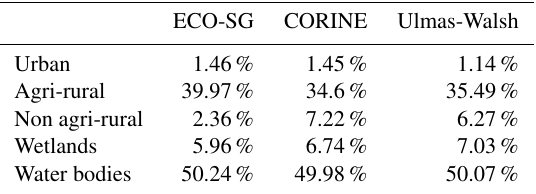
Table B2. Proportion of each of the 5 categories present in ECO- SG, CORINE and the UW map in percentage